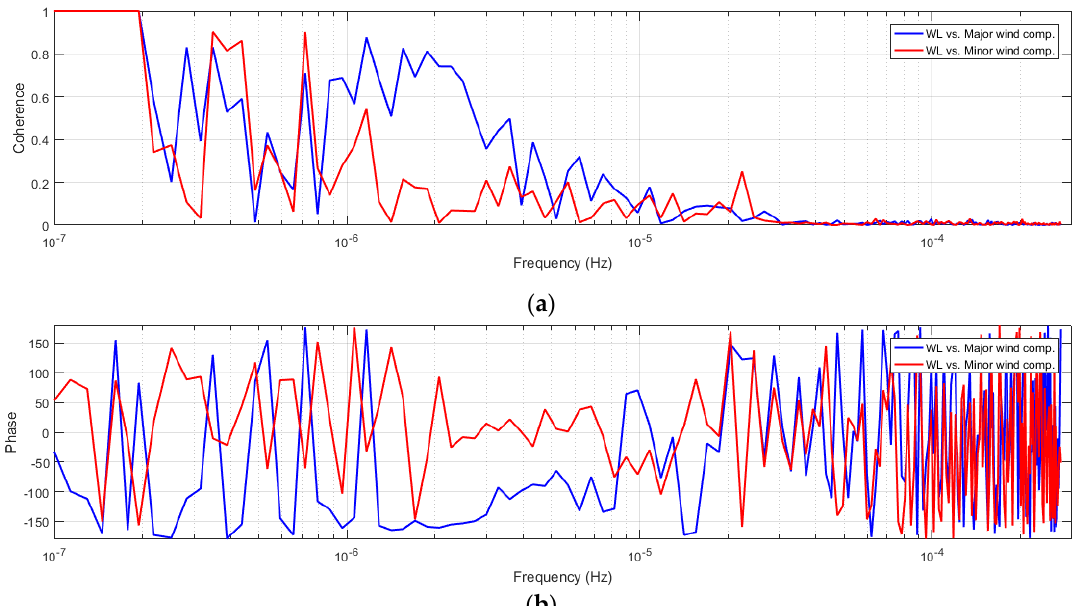
Figure 14. Cross spectrum of low ‐ frequency sea ‐ level records and wind velocity components at Bushehr station ( a ) coherence ( b ) phase difference.